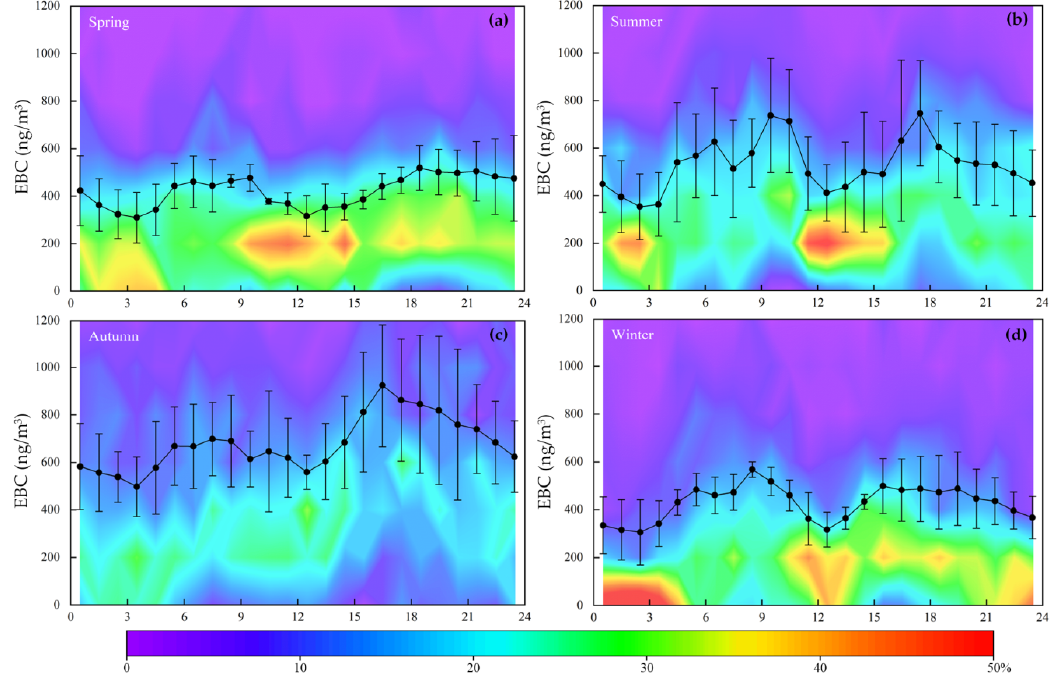
Figure 4. Hourly variations of EBC concentrations during four seasons. The black line represents the average EBC concentration, while the color map shows the frequency distribution of EBC (200 ng/m 3 per bin).